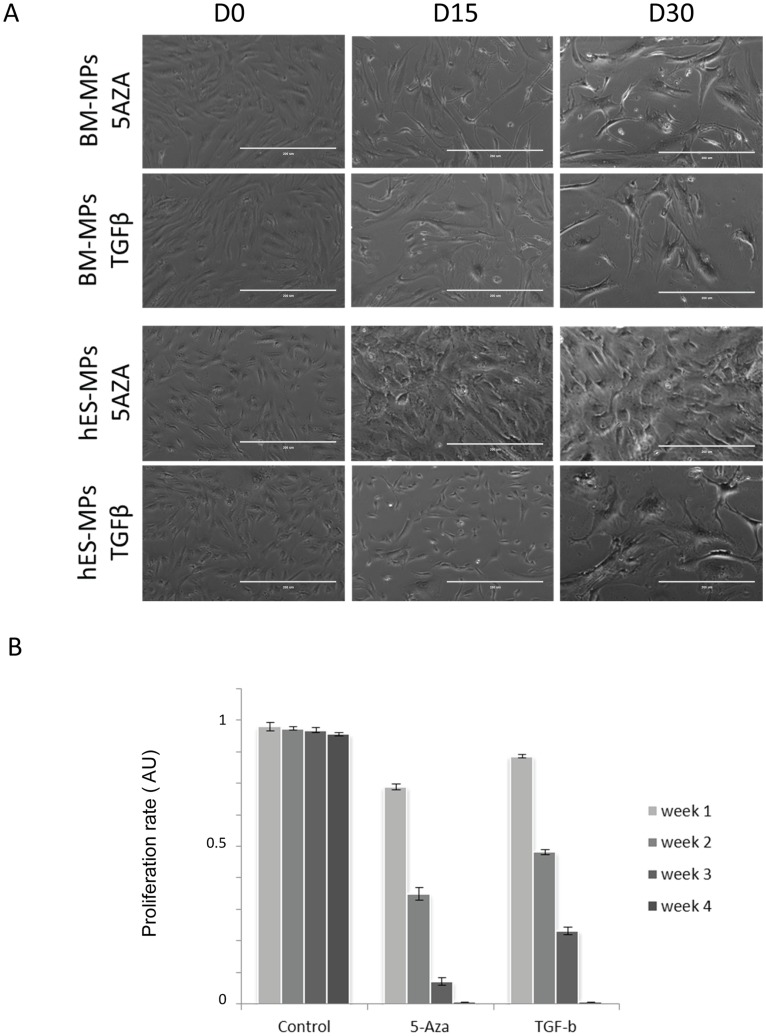
MPs modify their morphology and proliferation upon treatment with 5AZA or TGF-β1.A. Phase contrast imaging of the morphological modification of the hES-MPs or the BM-MPs after treatment with 5-AZA (10 µM )or TGF-β1 (10 ng ml−1). B. Proliferation of hESC-MPs treated with 5-AZA or TGF-β1 was evaluated using cell counting, charts demonstrating the reduction in proliferation over 4 weeks of treatment.